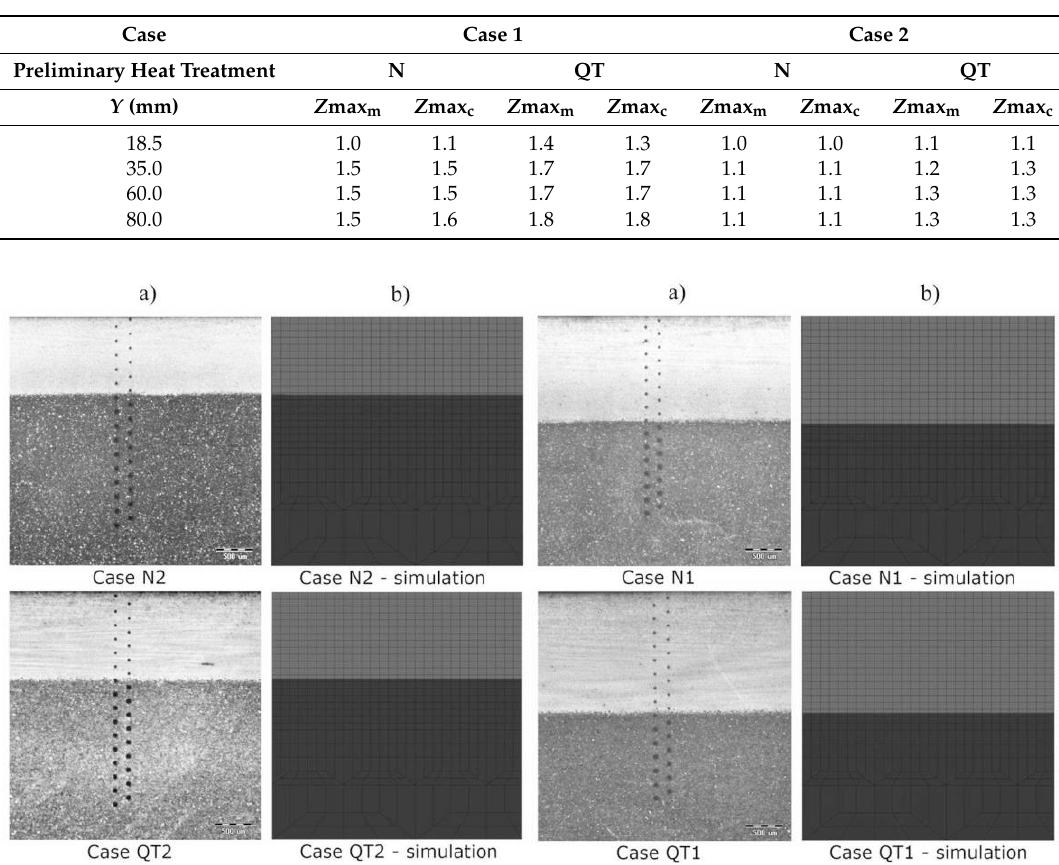
Figure 7. Comparison of martensite area in the real sample and as determined by computer simulation. ( a ) Experiment; ( b ) Simulation. Left panel: Case 1, right panel: Case 2.